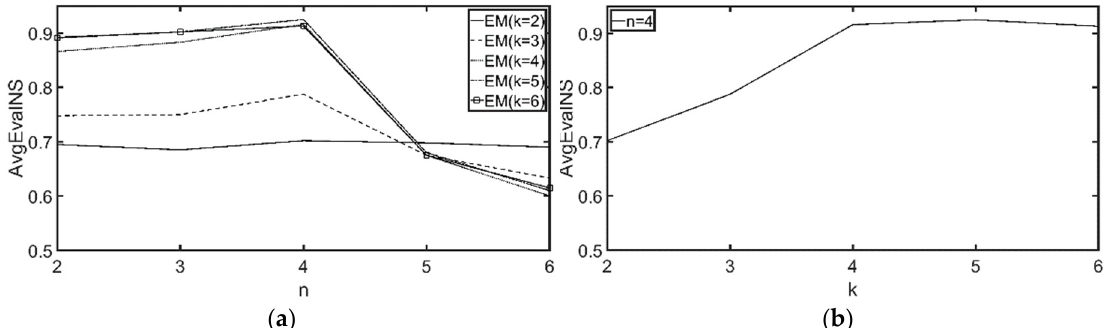
Figure 13. AvgEvalNS with ( α k = 4, α n = 4) resulting from different k , n. ( a ) resulting from different n . ( b ) resulting from different k .